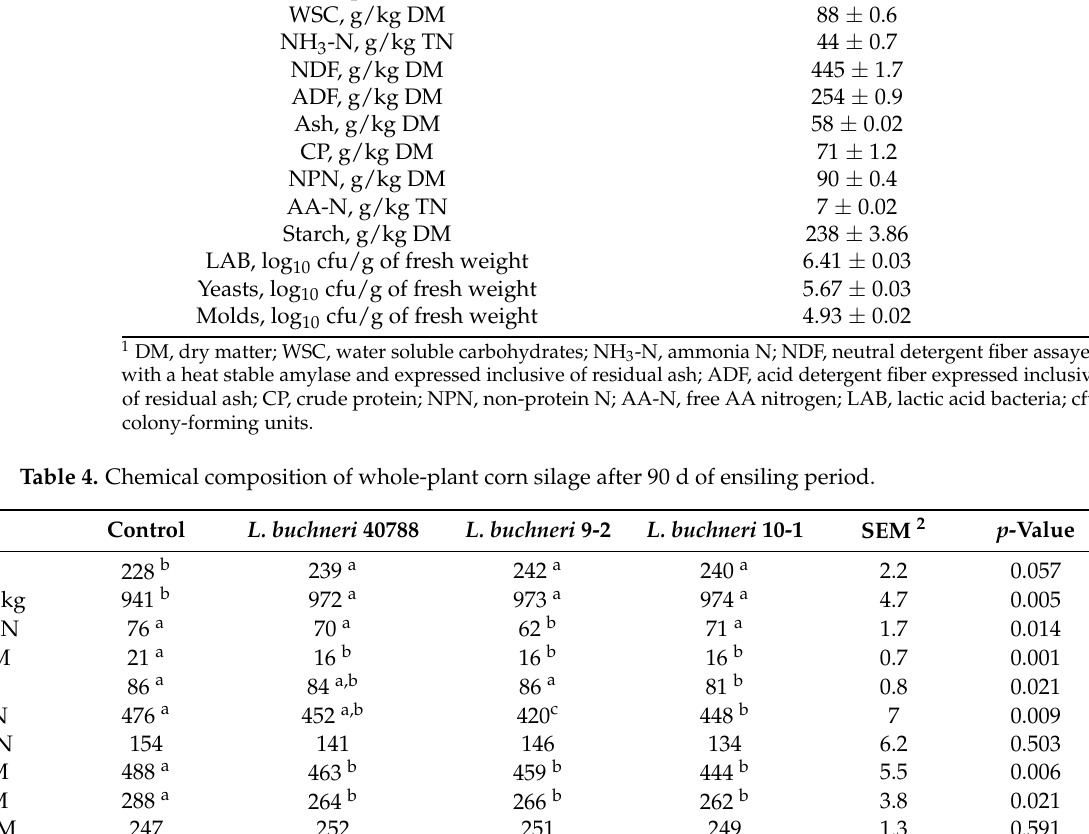
the NPN concentration in ensiled whole-plant corn and the lowest NPN was observed in L.